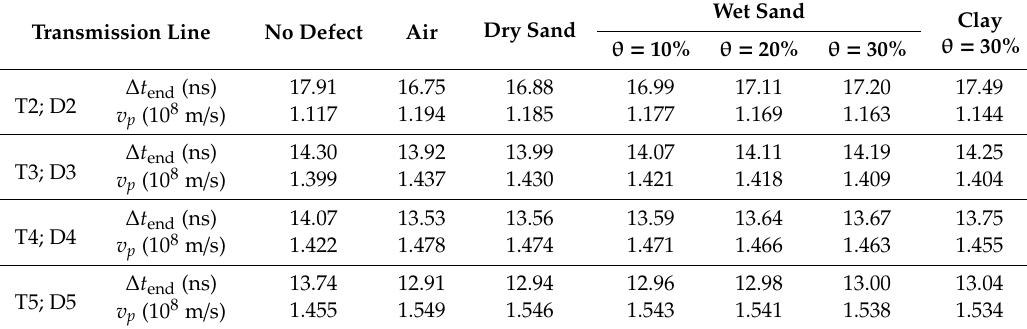
Table 2. Travel times of electromagnetic waves reflected from the ends ( Δ t end ) and velocities ( v p ) in the transmission lines.